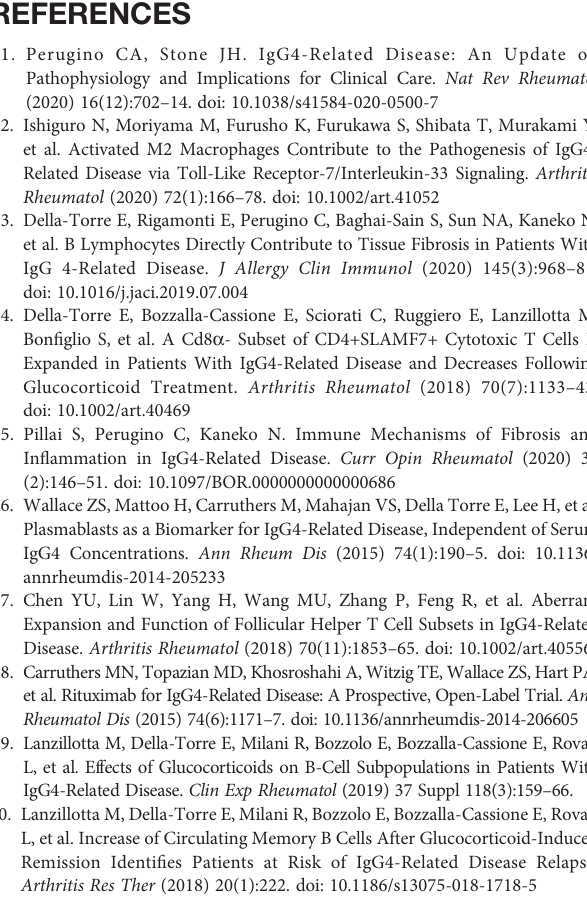
CD24intCD38int naive B cell, CD19+CD24+CD38- memory B cell, and CD19+ CD24hiCD38hi Breg. Supplementary Figure 4 | Results of statistical cluster analysis based on 10 B-cell subsets in the mixed cohort. Supplementary Figure 5 | Principal components selected based on B-cell subsets in patients with active IgG4-RD. (A) Scree plot for cluster analysis. (B) Principal component loading of two axes. Blue for negative and red for positive. PC1: principal component 1, PC2: principal component 2. Supplementary Figure 6 | Distribution of clinical phenotypes in each group. (A) Distribution of clinical phenotypes compared between Group1 and Group2 identi fi ed by 4 B-cell subsets. (B) Distribution of clinical phenotypes compared among subgroups identi fi ed by 10 B-cell subsets. Phenotype, Clinical phenotypes of IgG4-related disease. Supplementary Figure 7 | Differences in B cell subsets among patients with different IgG4-RD clinical phenotypes. (A) Four B-cell subsets compared among patients with different clinical phenotypes in initial cohort of active IgG4-RD. n=105, one patient met none of the 4 clinical phenotypes. Total B, CD19+ B cells; Plasmablasts, CD19+CD24-CD38hi; Naïve B, CD19+CD24intCD38int; Memory B cell, CD19+CD24+CD38-; Regulatory B cell, CD19+CD24hiCD38hi. (B) Ten B-cell subsets compared among patients with different clinical phenotypes in the internal cohort of active IgG4-RD. n=49, four patient met none of the 4 clinical phenotypes. Phenotype, Clinical phenotypes of IgG4-related disease. Values are the mean ± SD, with levels compared with the healthy control group highlighted in color (blue for decreased; red for